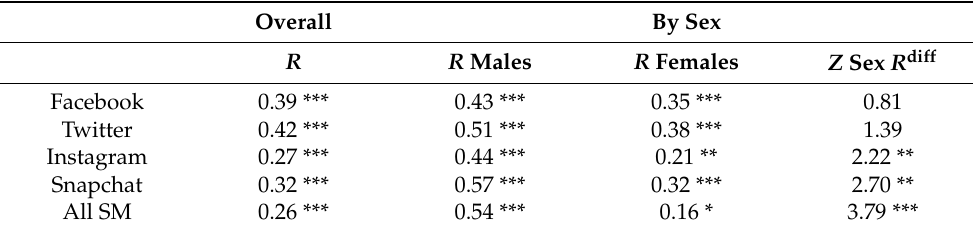
Table 2. Bivariate correlations between retrospectively self-reported and objectively assessed daily minutes spent on SM among all participants and self-reported users overall and by sex. Overall By Sex R R Males R Females